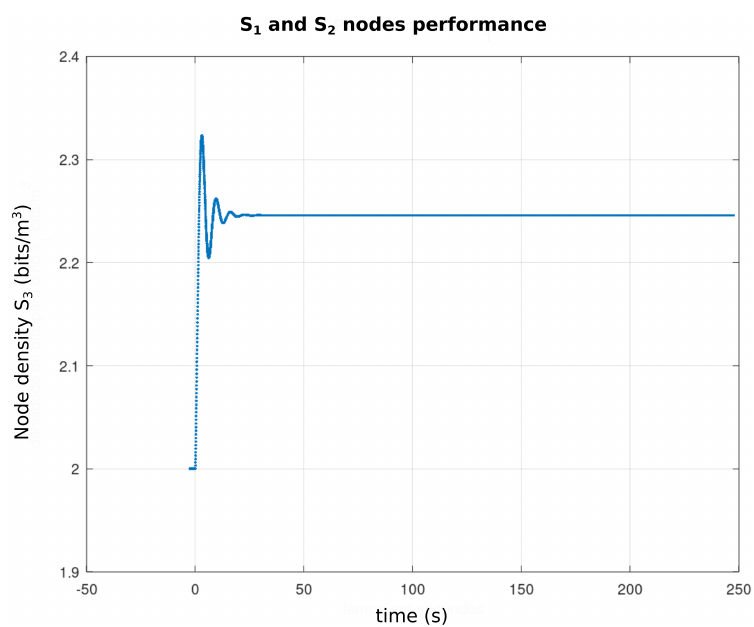
Figure 14. Performance graph of S 1 and S 2